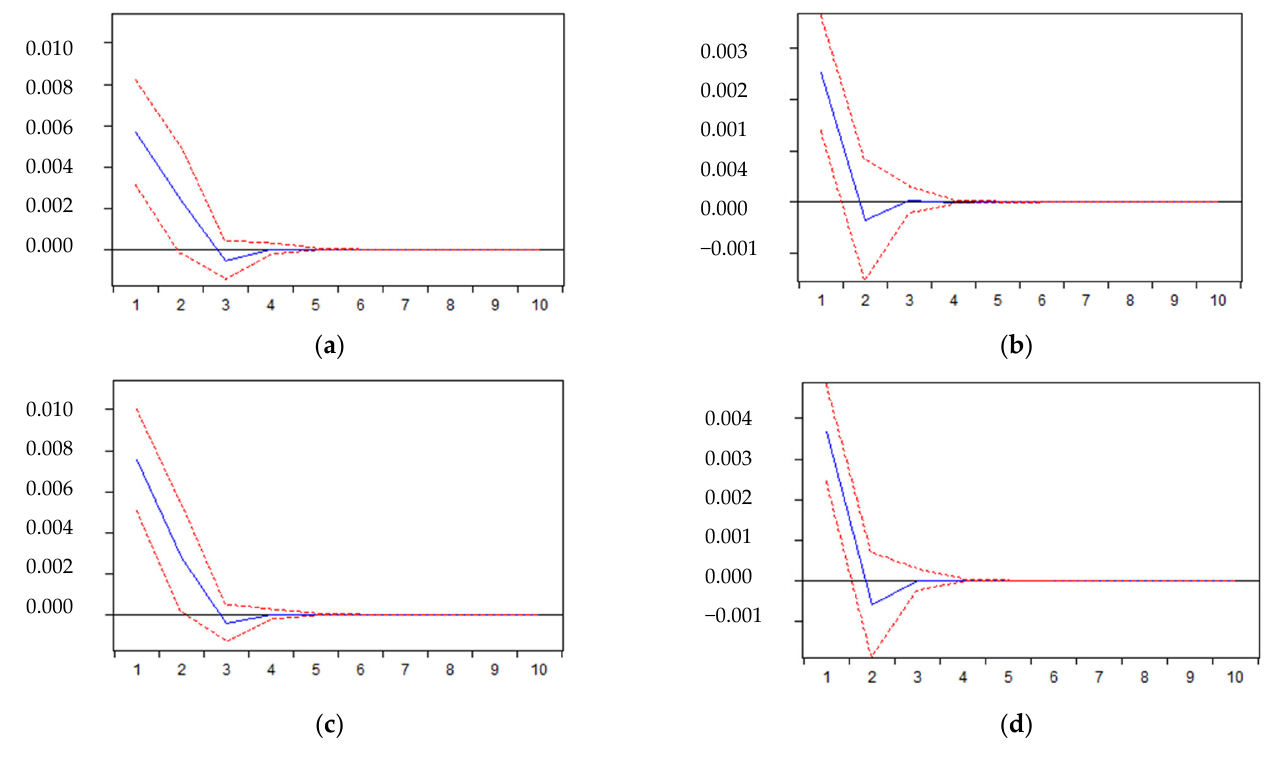
Figure 8. Generalized impulse response functions (post-vaccine period for oil-importing countries). ( a ) Response of oil to the DAX index. It is shown that when the DAX index price is shocked by one standard deviation shock, the oil price positively responds 1 day after the shock. ( b ) Response of the DAX index to oil. It is shown that when the oil price is shocked by one standard deviation shock, the DAX index price positively responds 1 day after the shock. ( c ) Response of oil to the CAC40 index. It is shown that when the CAC 40 index price is shocked by one standard deviation shock, the oil price positively responds 1 day after the shock. ( d ) Response of the CAC 40 index to oil. It is shown that when the oil price is shocked by one standard deviation shock, the CAC 40 index price positively responds 1 day after the shock.